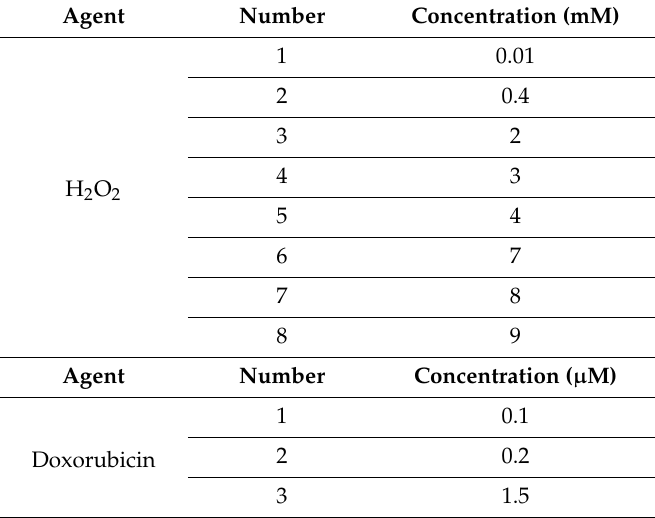
Table 1. Concentrations of doxorubicin and H 2 O 2 used in the